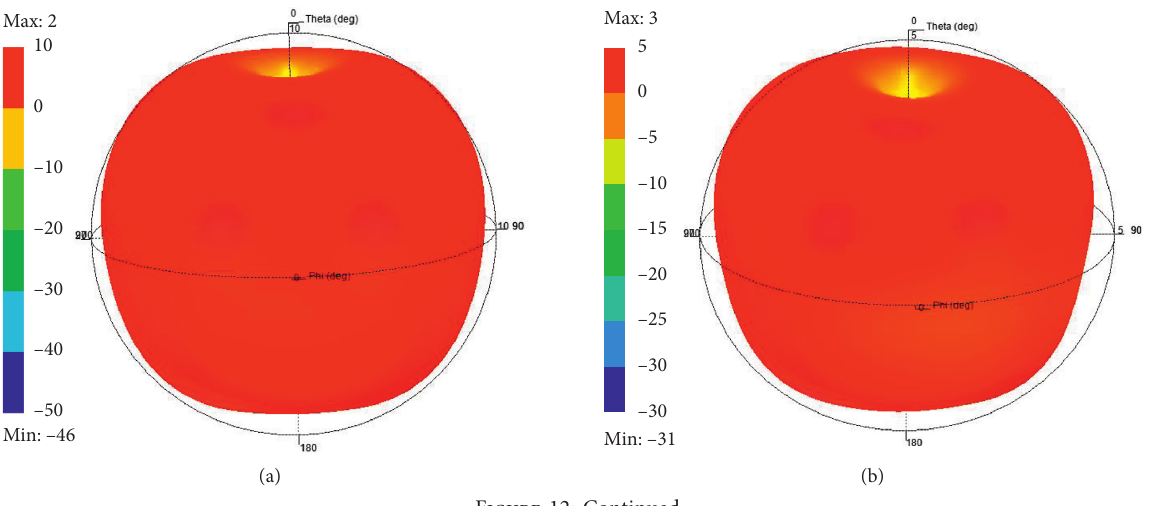
Figure 11: Distribution of electric field and equivalent magnetic current at 2.6GHz of the proposed triband patch antenna: (a) F (b) F y �